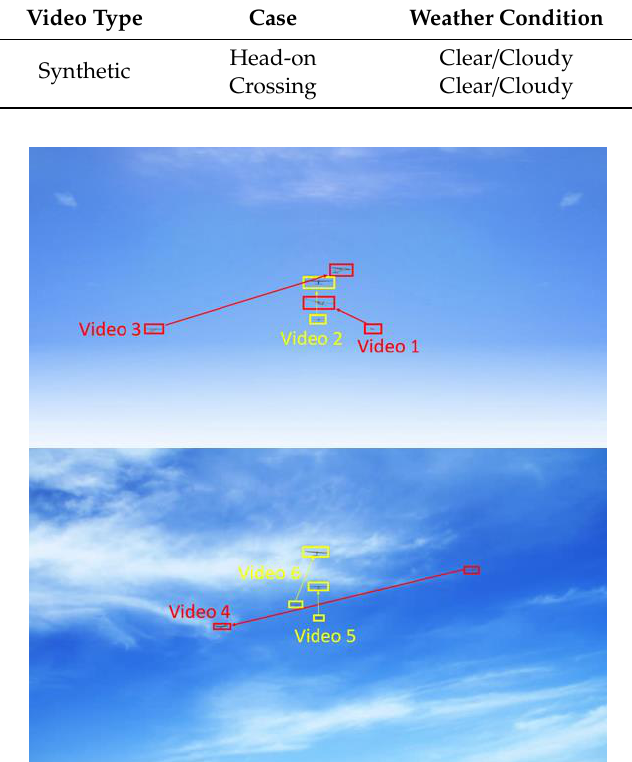
Figure 18. Synthetic videos for model evaluation. The red box indicates the crossing case, and the yellow box indicates the head-on case. yellow box indicates the head-on